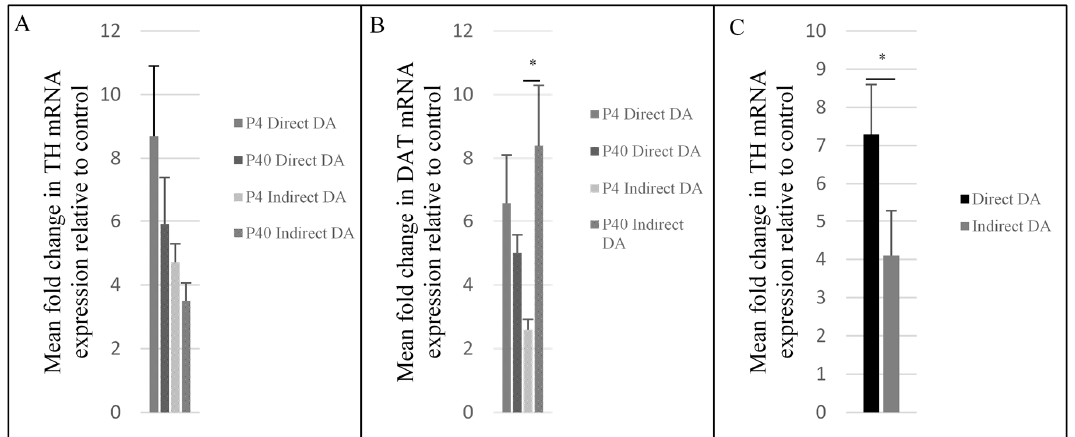
Figure 11. Results from qRT-PCR analyses. ( A ) TH mRNA expression relative to control was not